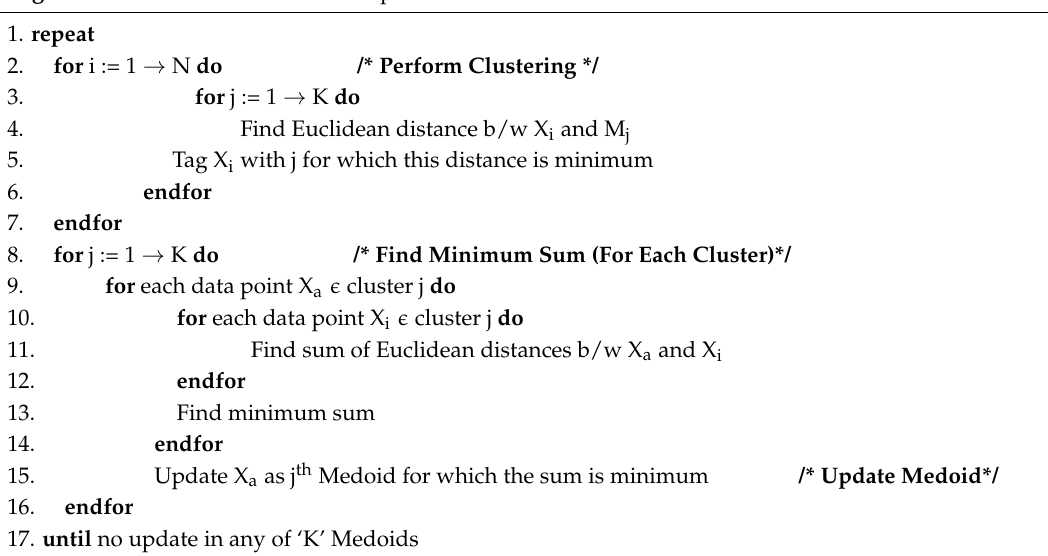
Algorithm 3. Pseudo-code of the Swap